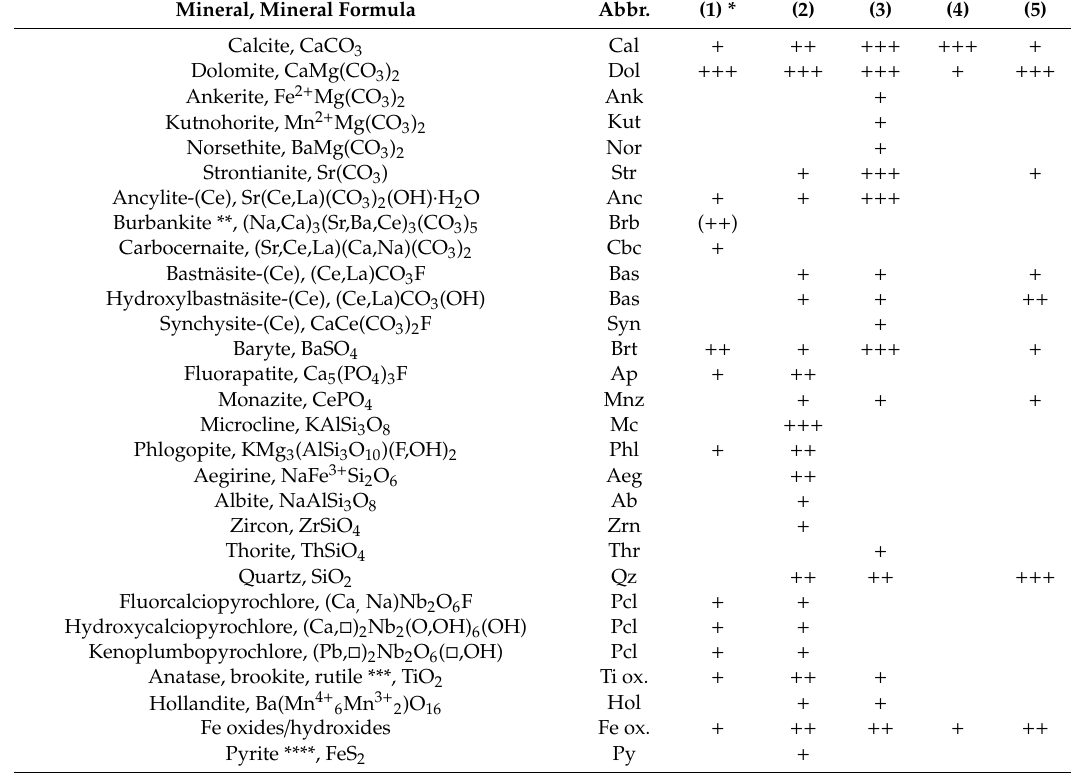
Table 1. Mineral composition of the Petyayan-Vara carbonatites. Mineral, Mineral